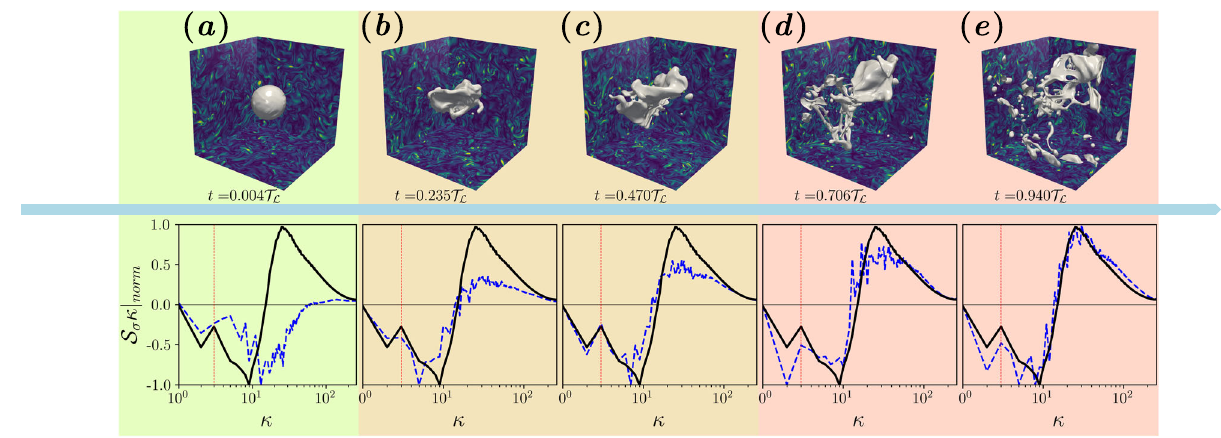
Fig. 3 Time-sequence of a single droplet breakup in turbulence. The simulation is performed at μ d / μ c = 1 and We L ¼ 42 : 6. The volume fraction is set to α = 0.0775 (1 droplet of diameter d), so that κ = 2 π / d ~ 3. Top panels show the temporal evolution of the interface during breakup, while vorticity is shown d on projected planes. Bottom panels show the surface tension energy transfer function S σ (see Eq. (2) and Material and Methods) normalized by its maximum values to improve readability. In each plot, in dashed-blue the instantaneous value of S σ (corresponding to the snapshot above), while the time- averaged value in statistical-stationary condition is reported using a black line. The dotted red line indicates κ d and time t is normalized with the large- eddies turnover time T L . The panels show the droplet deformation during the incipient (panel a with green background), the sub-critical (panels b and c with yellow background) and the super-critical (panels d and e with red background) states.The corresponding video is provided with the Supplementary Movie